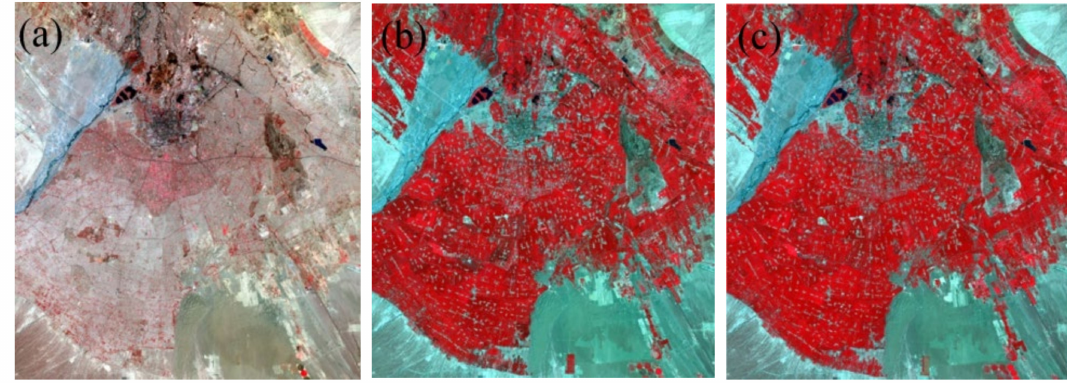
Figure 7. Landsat 8 standard false color image ( a ): 16 April 2013; ( b ): 5 June 2013; ( c ): 21 June 2013. The visual interpretation results between the fused images and the actual Landsat 8 LST images on 9 August 2014 are obtained from Figures 8 and 9. From the overall image (Figure 8b–d), the fusion result of ESTARFM and FSDAF is clearer than that of STARFM. In the subset (Figure 8e–h), the spatial detail of ESTARFM is the closest to the actual Landsat 8 LST, followed by FSDAF, and the STARFM result is the worst. However, for the fusion results of all three algorithms, the temperature was underestimated compared with the actual Landsat 8 LST. After analysis, it can be inferred that the cause is radiometric and geometric inconsistencies between the two sensors. The low-resolution data use simulated MODIS LST (resampled to 1000m based on Landsat 8 LST) in Figure 9, there is no underestimation in the subset, and the overall fusion accuracy has been improved. It can be seen that ESTRAFM still has the best fusion effect, which is the closest to the actual Landsat 8 LST, followed by FSDAF, and then STARFM.